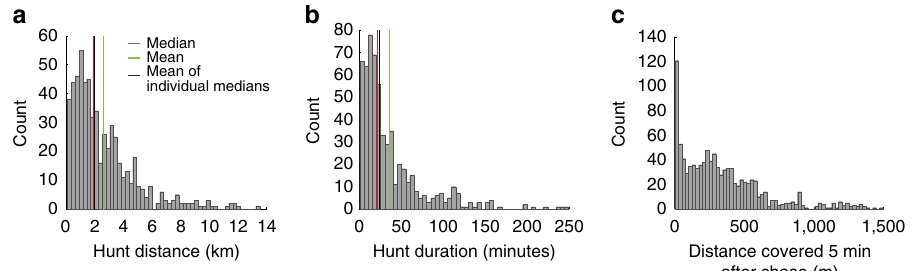
Figure 3 | Hunt parameters in African wild dogs. ( a ) Histogram of hunt distance covered from end of a chase to end of next chase by the same individual (the distance of 1,870 m used in the energetic calculation is the mean of the individual dog median values, n ¼ 1,119). ( b ) Histogram of time elapsed between end of one chase and end of next chase by the same individual ( n ¼ 1,119). ( c ) Histogram of distance covered by individual dogs in 5min after the end of each of their chases ( n ¼ 1,119, bin width 25m).